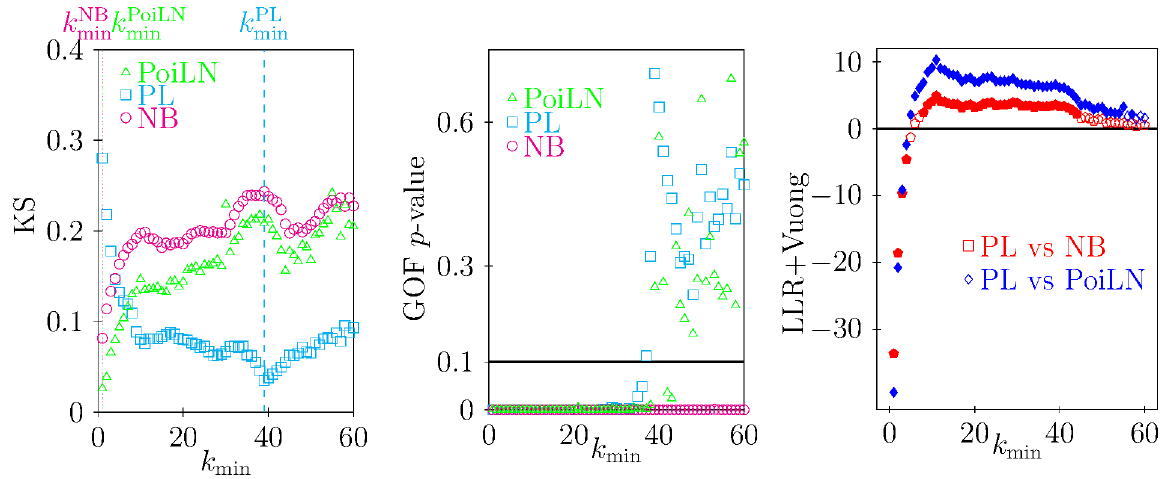
Figure 3. Comparison among fittings of distributions of ticks per host with different functions. Left: Kolmogorov-Smirnov statistic between subsets of data above k min and the fitting models on these subsets. Vertical dotted lines represent the optimum value of k min for different ~ k PoiLN ~ 1 , i.e. on the entire data set, models (NB: magenta; PoiLN: green; PL: cyan). For the NB and PoiLN models the optimum is observed for k NB min min ~ 38 . Center: goodness-of-fit p -value of fitting models on data larger than or equal to k while for the PL model the optimum is reached for k PL min . As min suggested by Clauset and collaborators [31] for p -value greater than 0.1 (horizontal line) the fitting model is a good description of the data. For NB the GOF is low ( p , 10 2 3 ), suggesting the inappropriateness of the NB model in describing the data. The GOF of the PoiLN indicates that the model is appropriate only for large value of k min , thus simultaneously with large values of KS and therefore pointing out the low performance of the model. The PL fits should not be rejected for values of k min larger than 35 concurrently with the lowest value of KS. Right: Log-likelihood Ratio (LLR) test with Vuong’s sign interpretation. Negative (positive) values suggest the alternative model NB (red) or PoiLN (blue) distributions are (are not) favoured in describing values larger than k min when compared to PL. The horizontal line shows the sign threshold. Full marks show statistically significant tests ( p , 0.05) while empty marks refer to non significant tests ( p . 0.05).